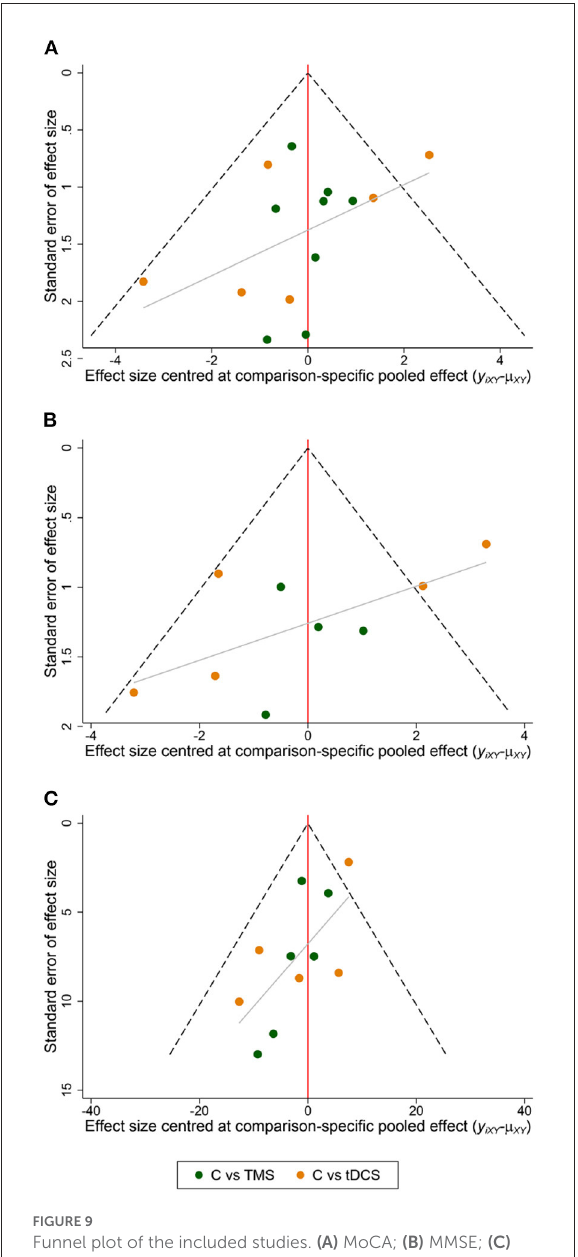
FIGURE9 Funnel plot of the included studies. (A) MoCA; (B) MMSE; (C) MBI,